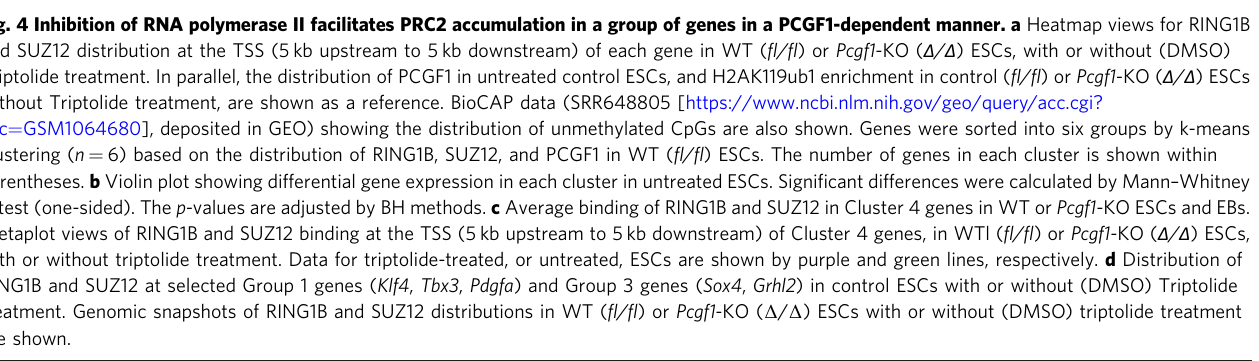
Fig. 4 Inhibition of RNA polymerase II facilitates PRC2 accumulation in a group of genes in a PCGF1-dependent manner. a Heatmap views for RING1B and SUZ12 distribution at the TSS (5 kb upstream to 5 kb downstream) of each gene in WT ( fl / fl ) or Pcgf1 -KO ( Δ / Δ ) ESCs, with or without (DMSO) Triptolide treatment. In parallel, the distribution of PCGF1 in untreated control ESCs, and H2AK119ub1 enrichment in control ( fl / fl ) or Pcgf1 -KO ( Δ / Δ ) ESCs without Triptolide treatment, are shown as a reference. BioCAP data (SRR648805 [https://www.ncbi.nlm.nih.gov/geo/query/acc.cgi? acc = GSM1064680], deposited in GEO) showing the distribution of unmethylated CpGs are also shown. Genes were sorted into six groups by k-means clustering ( n = 6) based on the distribution of RING1B, SUZ12, and PCGF1 in WT ( fl / fl ) ESCs. The number of genes in each cluster is shown within parentheses. b Violin plot showing differential gene expression in each cluster in untreated ESCs. Signi fi cant differences were calculated by Mann – Whitney U test (one-sided). The p -values are adjusted by BH methods. c Average binding of RING1B and SUZ12 in Cluster 4 genes in WT or Pcgf1 -KO ESCs and EBs. Metaplot views of RING1B and SUZ12 binding at the TSS (5 kb upstream to 5 kb downstream) of Cluster 4 genes, in WTl ( fl / fl ) or Pcgf1 -KO ( Δ / Δ ) ESCs, with or without triptolide treatment. Data for triptolide-treated, or untreated, ESCs are shown by purple and green lines, respectively. d Distribution of RING1B and SUZ12 at selected Group 1 genes ( Klf4 , Tbx3 , Pdgfa ) and Group 3 genes ( Sox4 , Grhl2 ) in control ESCs with or without (DMSO) Triptolide treatment. Genomic snapshots of RING1B and SUZ12 distributions in WT ( fl / fl ) or Pcgf1 -KO ( Δ / Δ ) ESCs with or without (DMSO) triptolide treatment are shown.